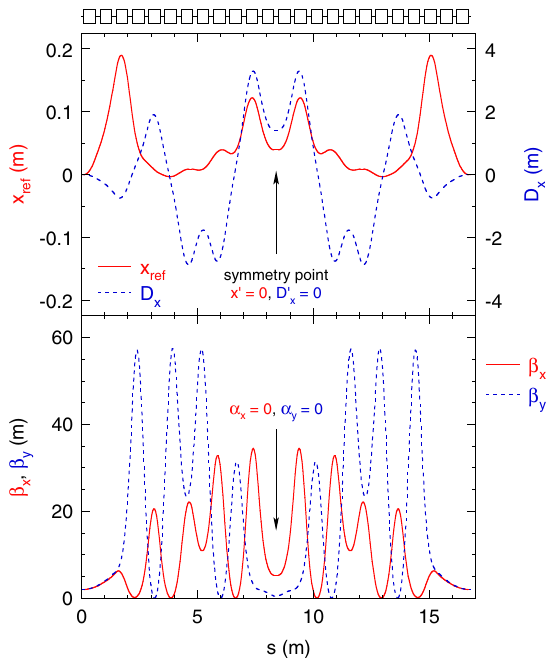
FIG. 3. 1 : 2 GeV =c optics of an outward-bending superperiod: the horizontal reference orbit x ref and dispersion D x (top) and the horizontal and vertical (cid:1) functions (bottom).